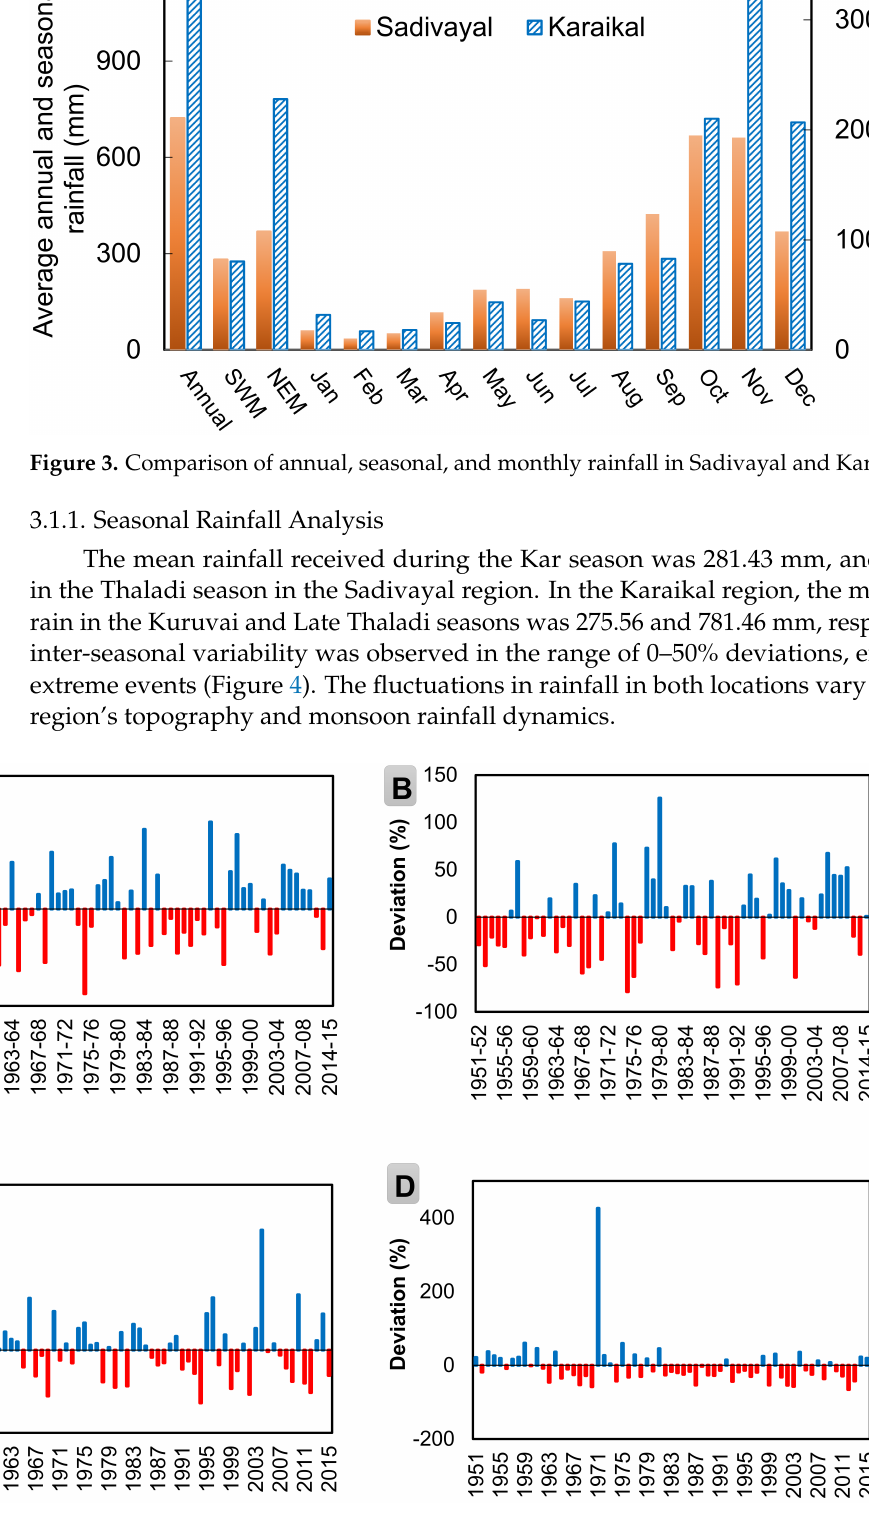
Figure 4. Seasonal rainfall deviation with the long-term mean of 65 years. ( A ) Late Thaladi Season (NEM) in Karaikal, ( B ) Thaladi Season (NEM) in Sadivayal, ( C ) Kuruvai Season (SWM) in Karaikal, and ( D ) Kar Season (SWM) in